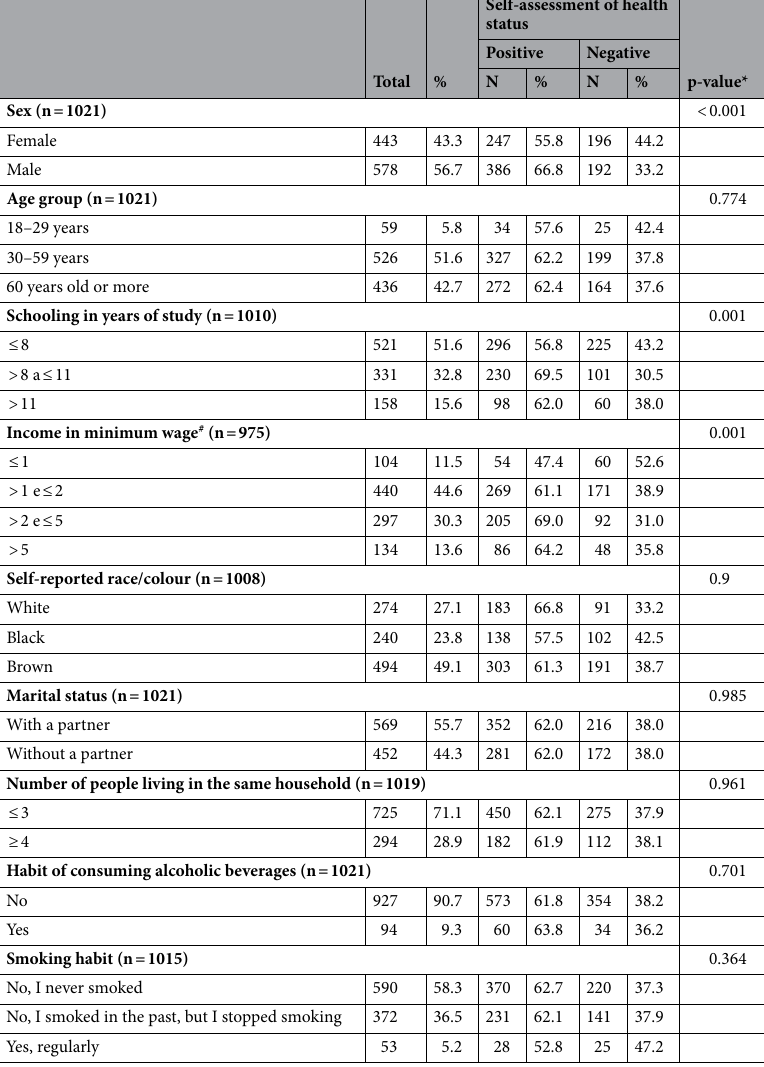
Table 1. Distribution of sociodemographic characteristics and life habits according to self-assessment of health status. *Chi-square. # Value of minimum wage in Brazil (September 2019): R$998.00; USD =